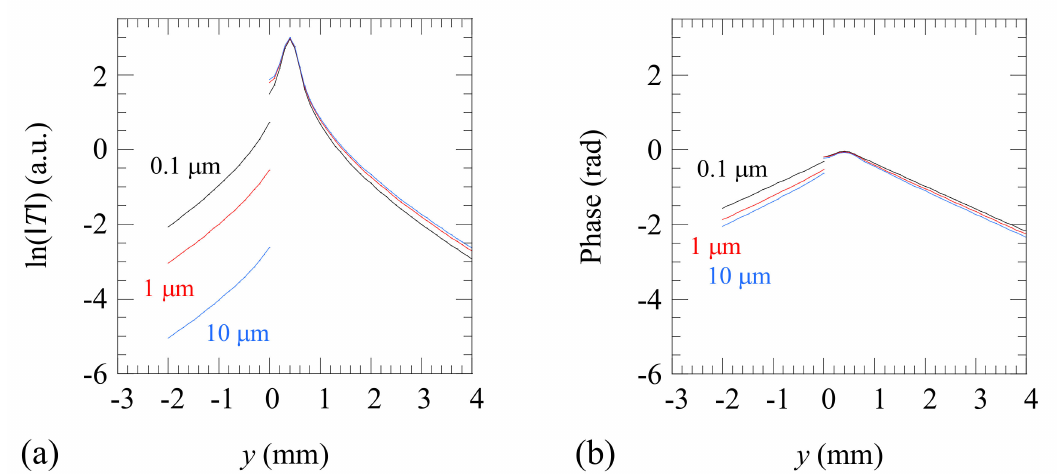
Figure 2. Calculations of ( a ) ln(| T |) and ( b ) phase along the y -axis for an Al-alloy sample ( D = 42 mm 2 /s, K = 100 W m − 1 K − 1 ) containing an infinite vertical crack, located at y = 0. Three crack widths are considered: w = 0.1, 1, and 10 µ m. The sample is illuminated by a Gaussian laser beam of power P o = 1 W modulated at f = 5 Hz. The laser spot has a radius of a = 0.2 mm, and it is located at a distance l = 0.4 mm from the